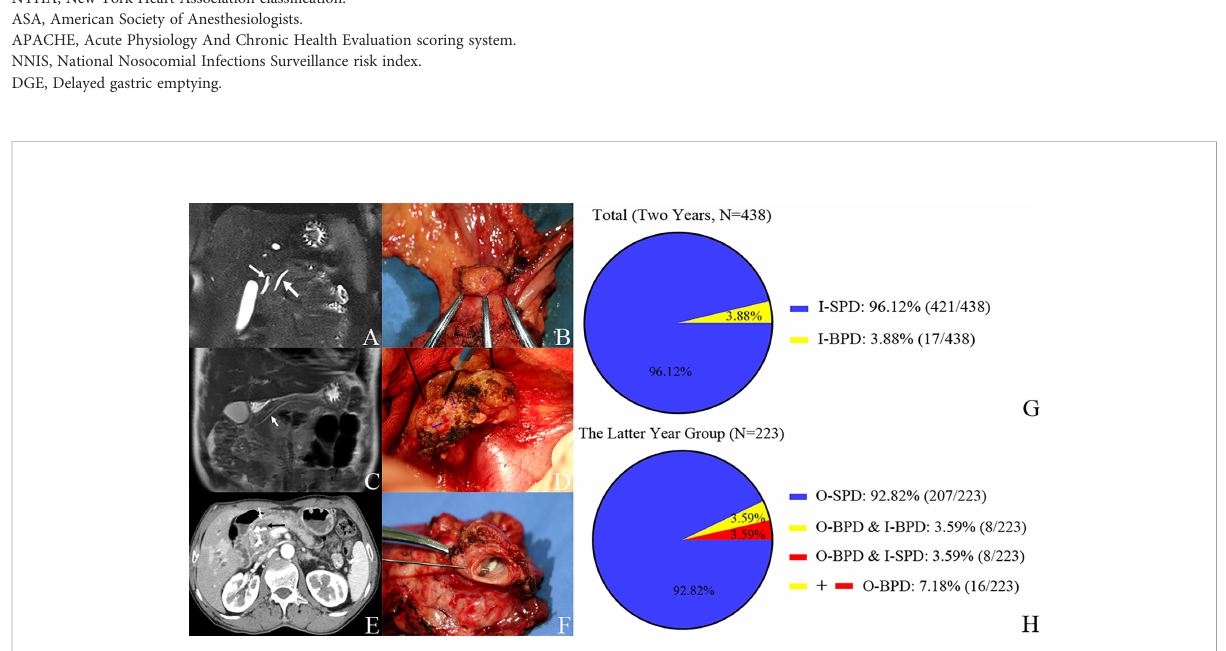
FIGURE 2 Pancreatic duct in preoperative imaging and operation and the incidence of bi fi d pancreatic duct. Case 1. (A) I-SPD vs. (B) O-SPD. (A) I-SPD: common bile duct (left arrow) and main pancreatic duct (right arrow) in preoperative imaging. (B) O-SPD: one pancreatic duct ori fi ce in